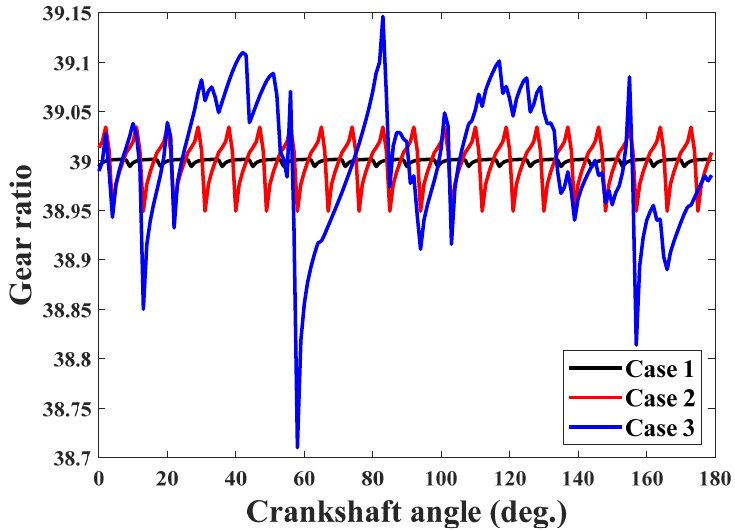
Figure 15. Comparisons of the instantaneous gear ratio for three cases.